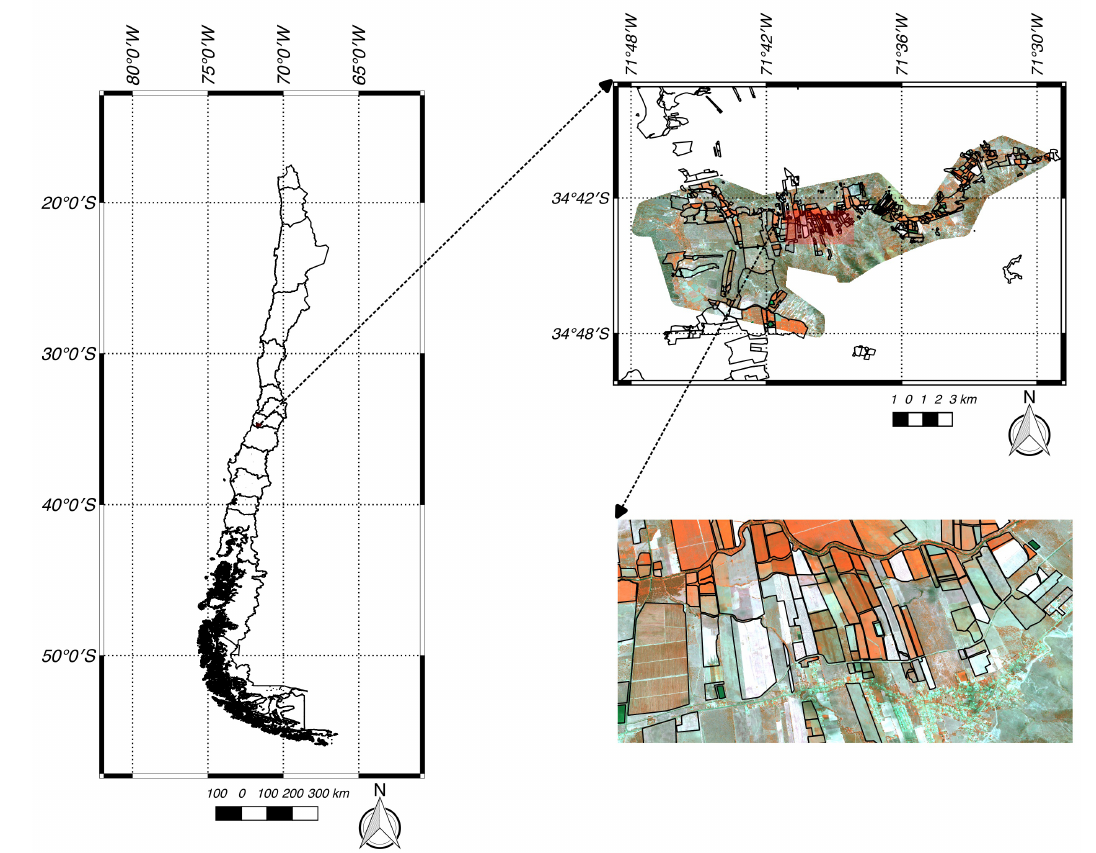
Figure 1. Study site, located in the Lolol Valley, O’Higgins Region, Chile.